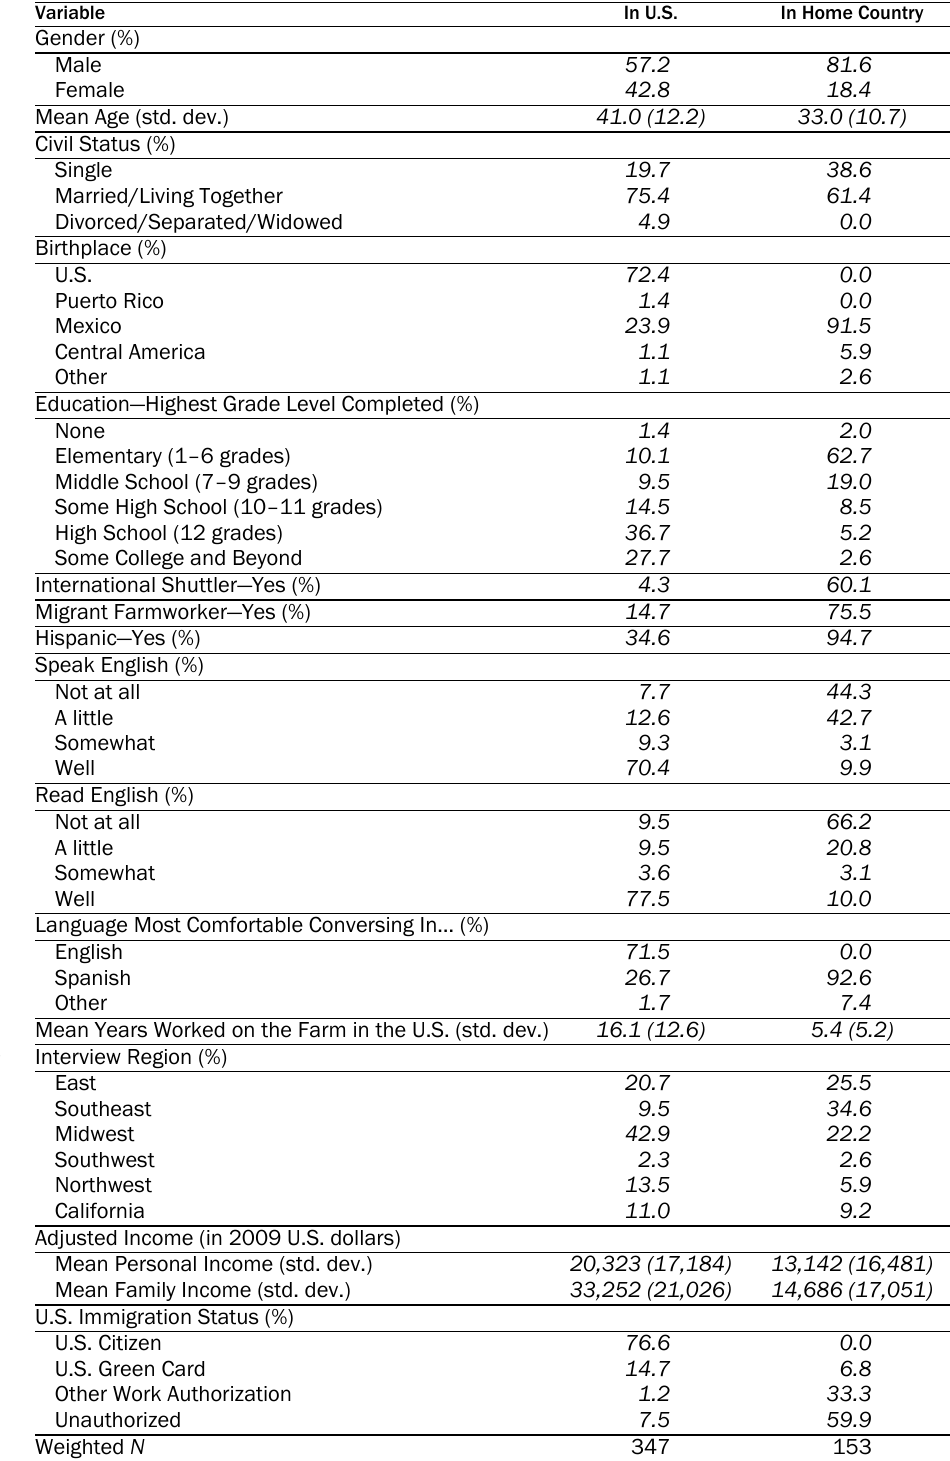
Table 3. U.S. Farmworker Business Ownership Demographics at Time of Survey (1989–2009) by Country